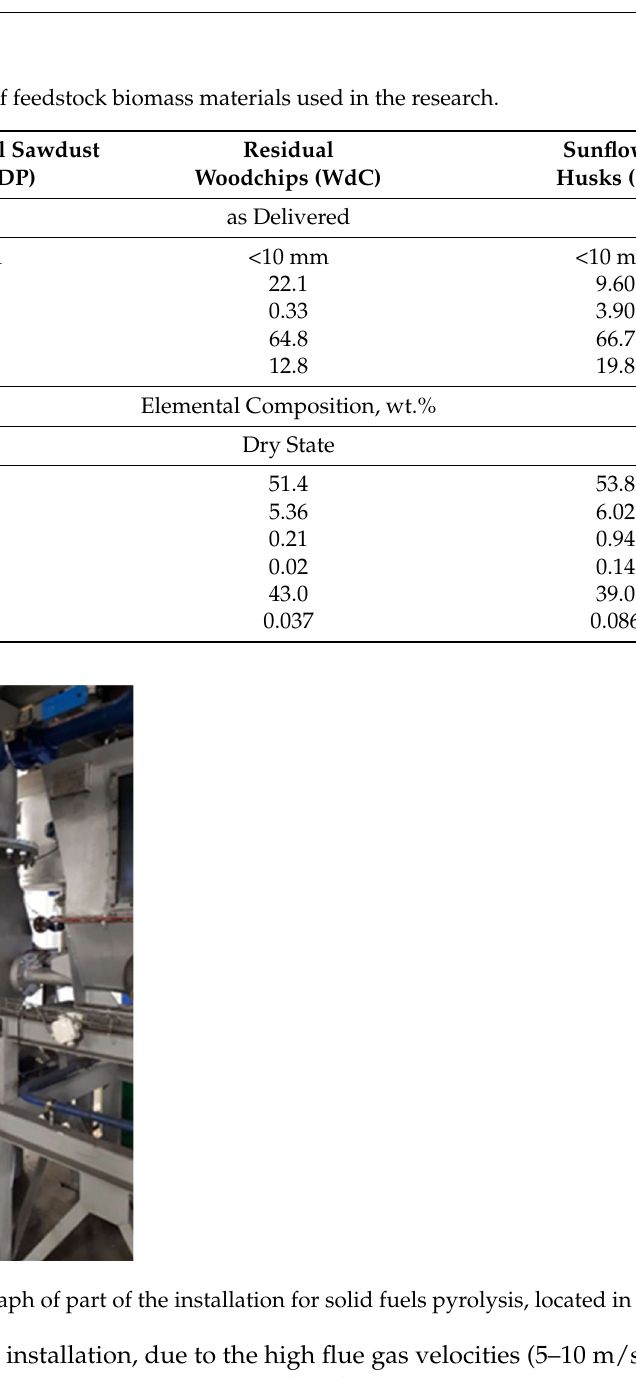
Table 1. Characteristics of feedstock biomass materials used in the research.